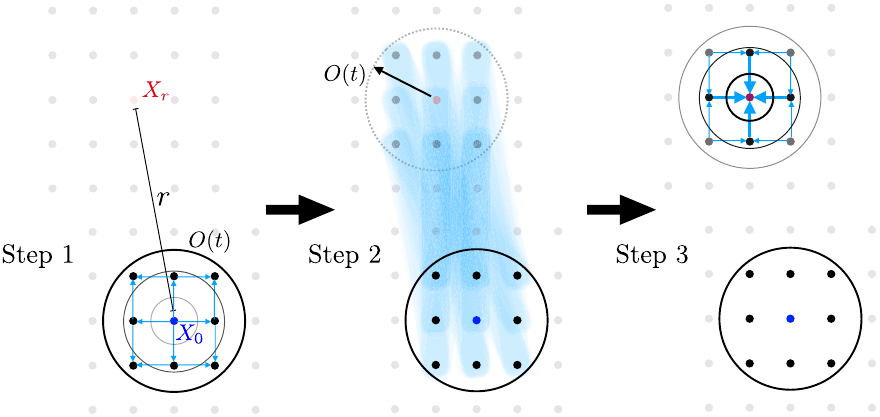
FIG. 4. A protocol for rapid growth of the commutator norm using two-body long-range interactions. Step 1: We use CNOT gates between nearest-neighbor sites to spread a single Pauli X 0 to a Pauli string XX … X supported on every site inside a ball of radius O ð t Þ centered at X 0 . Step 2: We use pairwise ZZ interactions between all sites in the two balls, located distance O ð r Þ apart, which adds an operator of norm ∼ O ð t 2 d þ 1 =r α Þ into the second ball a distance r away. Step 3: We invert step 1 in the outer ball, pushing all of the operator weight in the outer ball onto a single